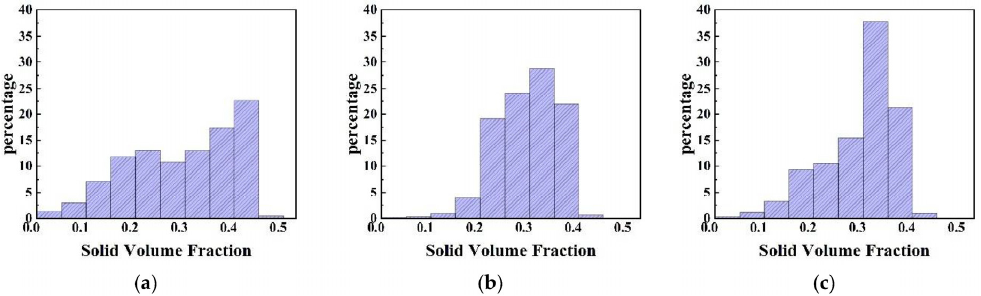
Figure 23. Histogram of solid distribution for DRFTBI with different off-bottom clearance. ( a ) T/3; ( b ) T/4; and ( c ) T/5. (Rotational speed: 120 rpm; solid loading: 30%; connection strap length: 1.2